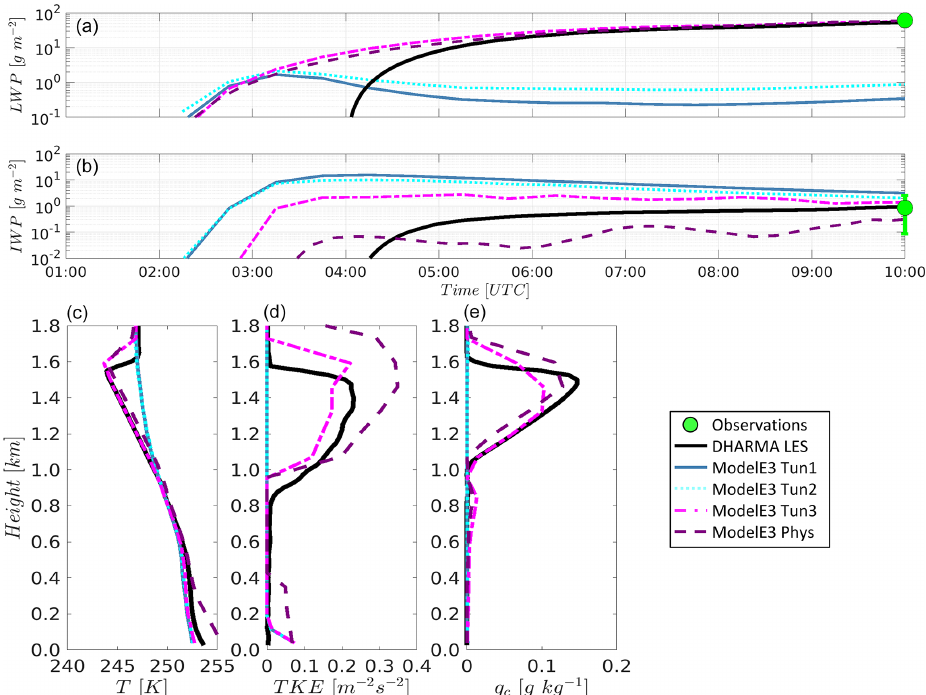
Figure B1. Time series showing (a) liquid water path (LWP) and (b) ice water path (IWP) in each case study simulation using the DHARMA LES (baseline simulation in Silber et al., 2019a), and the four ModelE3 configurations (Tun1, Tun2, Tun3, and Phys). The Eulerian retrievals shown for 10:00UTC (error bars denote uncertainty) correspond to the time at which the Lagrangian simulated domain approaches McMurdo Station (see Sect. 3.2). (c, d, e) Temperature, turbulent kinetic energy, and cloud water mixing ratio profiles at the end of the SCM and DHARMA LES